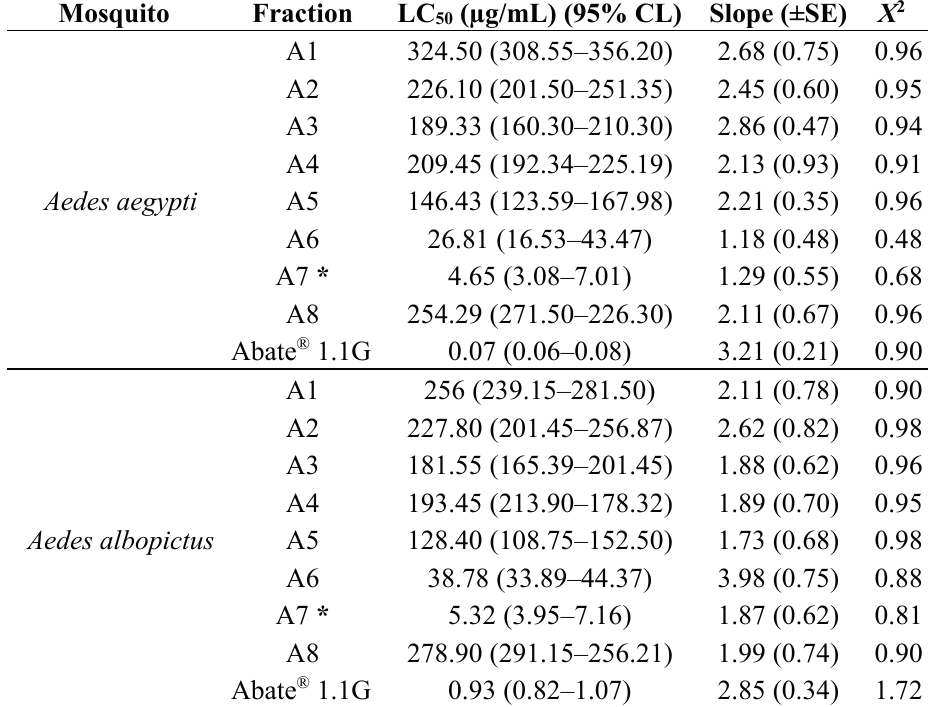
Table 3. Larvicidal activity of the fractions derived from chloroform extract of Bryopsis pennata against Aedes aegypti and Aedes albopictus